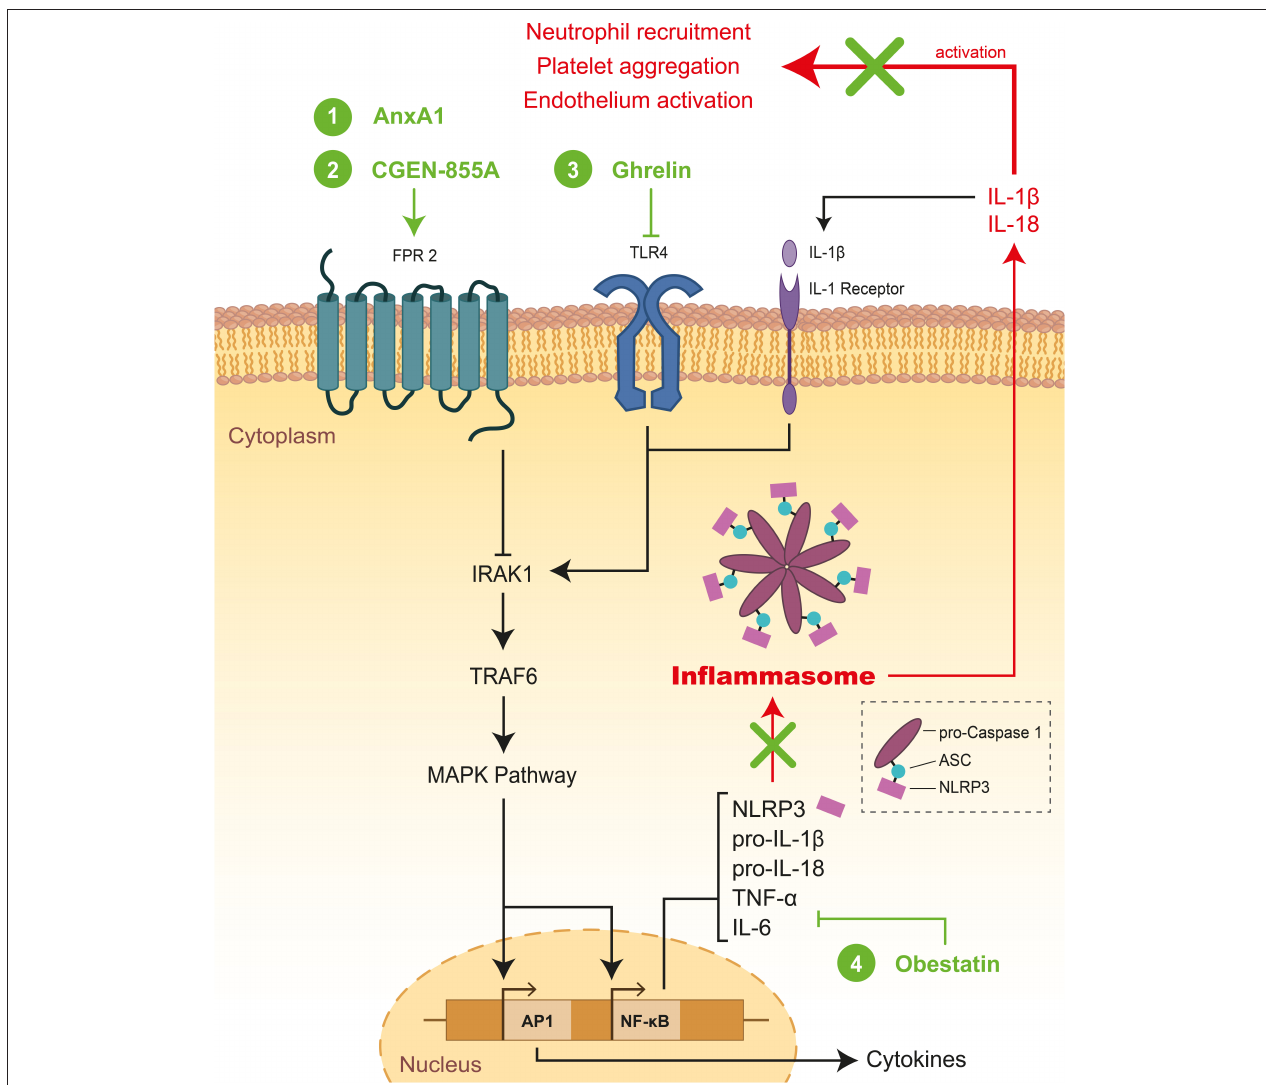
FIGURE 4 | Schematic representation of inflammation and mode of action of therapeutic peptides during MIRI. FPR, TLR4, or IL1 receptors activate the MAPK pathway through IRAK1 and TRAF6. Afterward, the MAPK pathway activates the expression of NLRP3 which formed the inflammasome together with pro Caspase-1 and ASC (Apoptosis-associated speck like protein containing a Caspase recruitment domain) contributing to the strong but short inflammatory burst. Secretion of mature forms of IL-18 and IL-1 β activate neutrophil recruitment, platelet aggregation, and endothelium activation. Therapeutic peptides reducing inflammation during MIRI were highlighted in green: (1) AnxA1, (2) CGEN-855A, (3) Ghrelin, and (4) Obestatin. FPR, Formyl peptide receptor; TLR4, Toll-Like Receptor 4; IL1, Interleukin 1; IRAK1, Interleukin 1 Receptor Associated Kinase 1; TRAF6, TNF receptor-associated factor 6; NLRP3, NOD-, LRR- and pyrin domain-containing protein